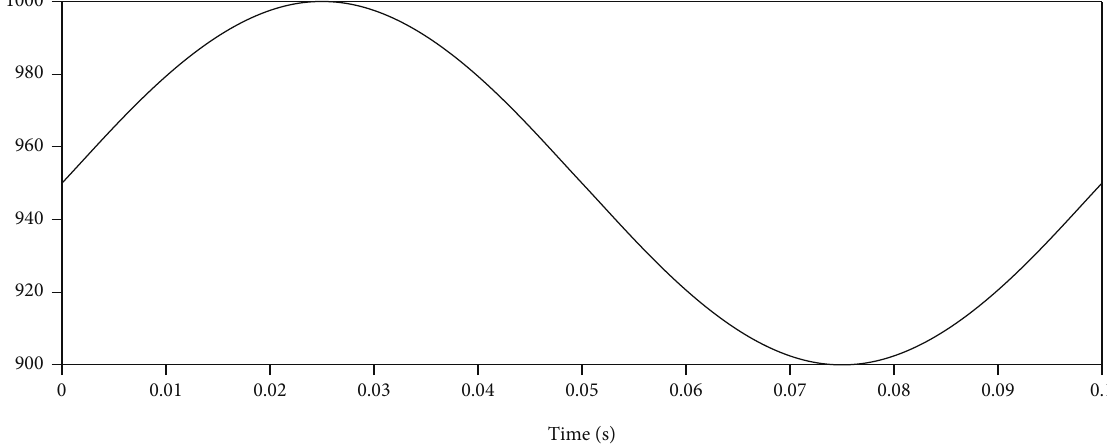
Figure 14: Sinusoidal variation of solar